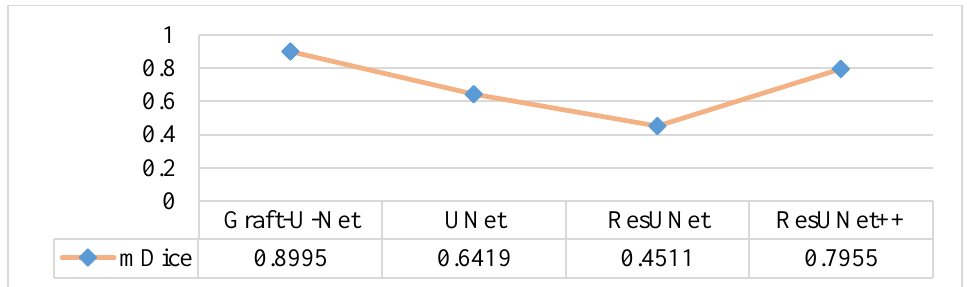
Figure 12. Comparison of Graft-U-Net on CVC-ClinicDB Dataset in terms of mDice. The results of Graft-U-Net (0.8138) in terms of mIoU are compared with the pre-study models of UNet (0.4711), ResUNet (0.4571), and ResUNet++ (0.7962). The comparison that